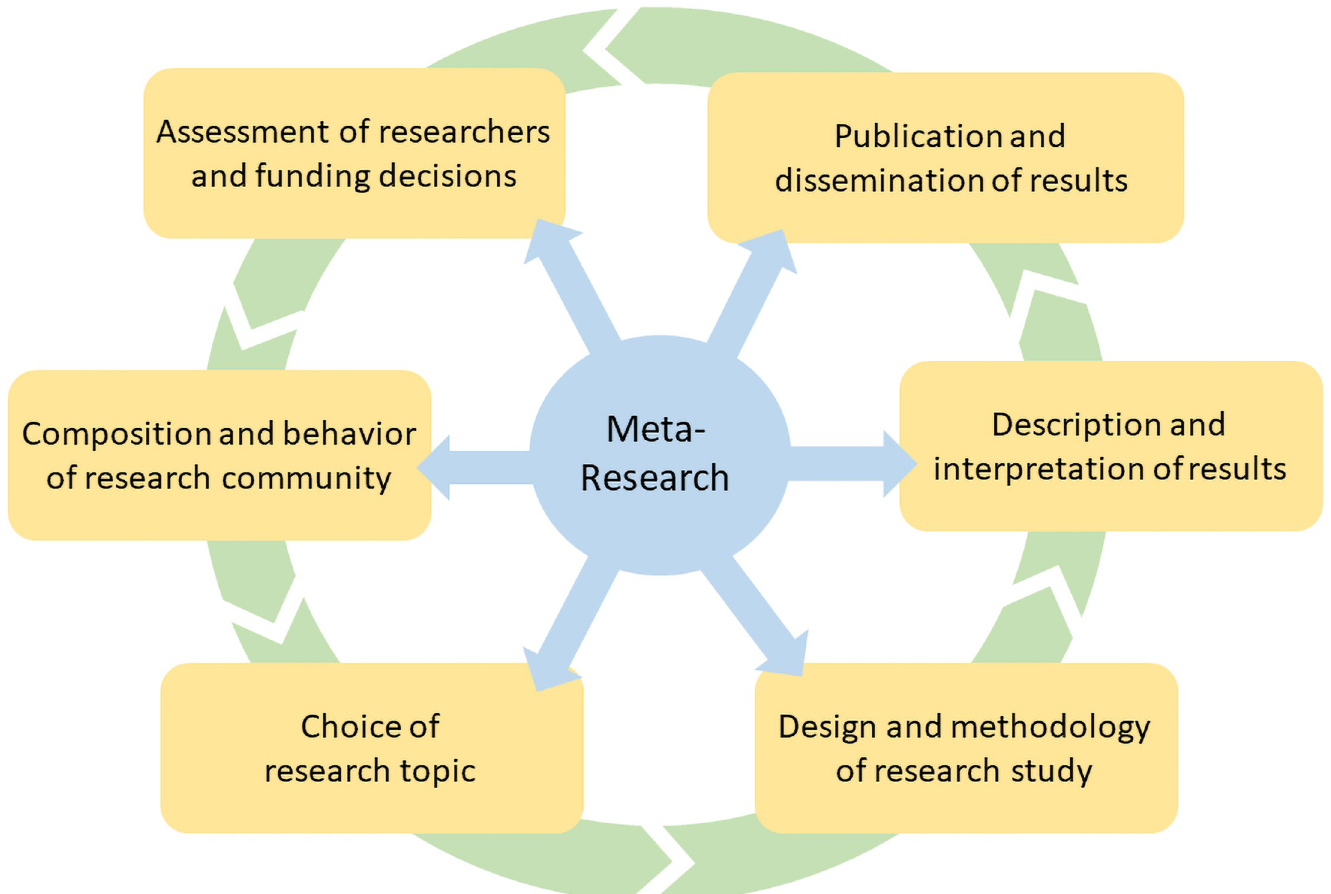
Fig 1. Meta-research interrogates all stages of the research